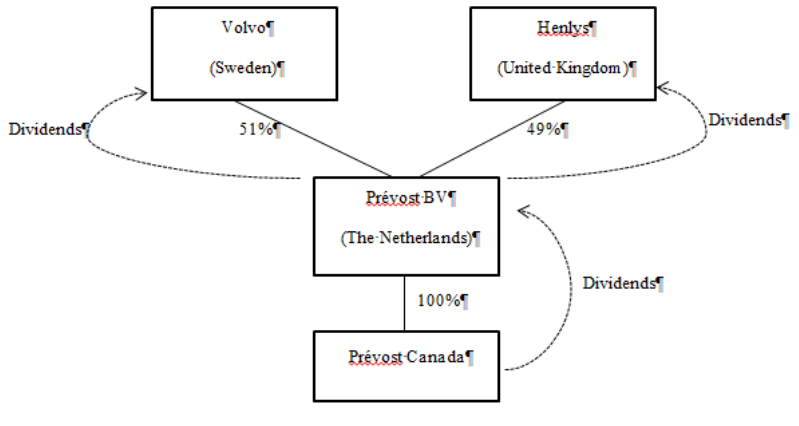
FIGURE 2: The corporate structure in the Prévost case Source: Vitko, 2011